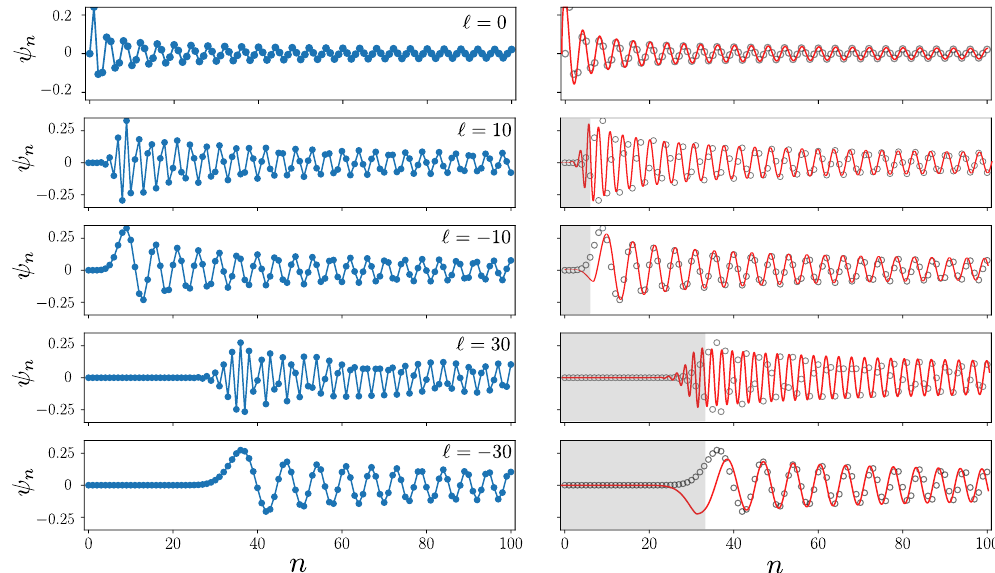
Figure 7: Some of the eigenstates of the lattice model with linearly varying hopping. Left and right panels respectively show the results of exact diagonalization on a lattice with 101 sites, and the corresponding analytical approximation given by Eq. (49). The eigenstates are labeled with integer numbers (cid:96) in the range of ( − [ N / 2 ] , [ N / 2 ]) such that the zero mode corresponds to (cid:96) = 0. The energy of states with (cid:96) = ± 10 and (cid:96) = ± 30, are obtained numerically to be (cid:34) = ± 0.14 and (cid:34) = ± 0.67, respec- tively. For the sake of comparison, the right panels also display the numerical results with empty circles, indicating the good agreement with the approximate analytical functions shown in red solid